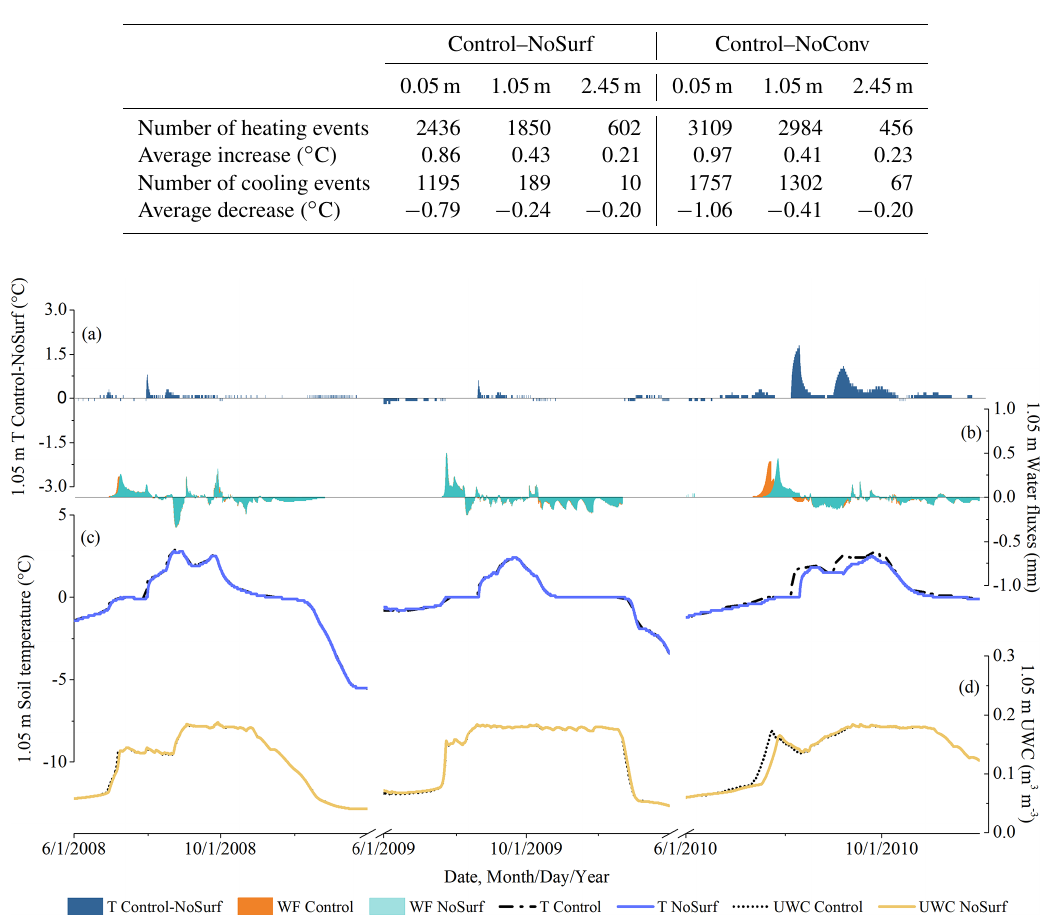
Figure 8. Hourly soil temperature, water flux, and UWC at 1.05m depth, representative of intermediate depths, simulated under NoSurf and Control during the 2008–2010 thaw periods. The same notations as in Fig. 6 are